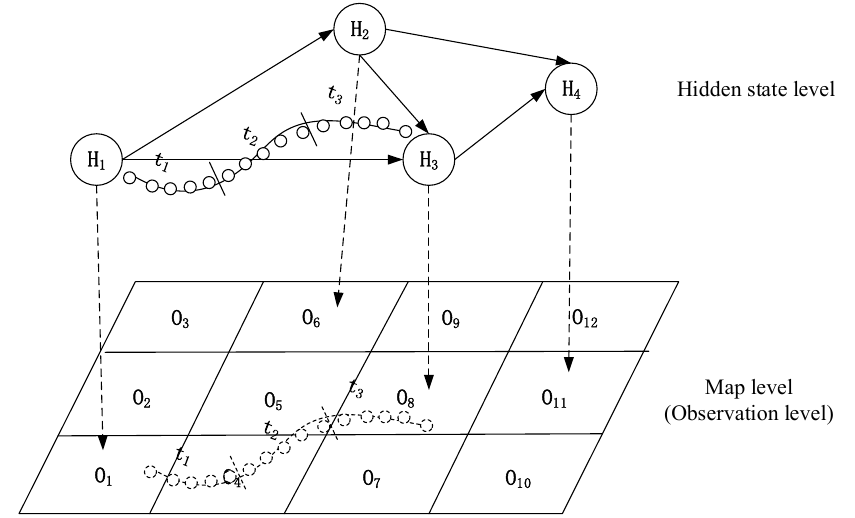
Figure 2. An example of predictive modeling based on the hidden Markov model (HMM). 229